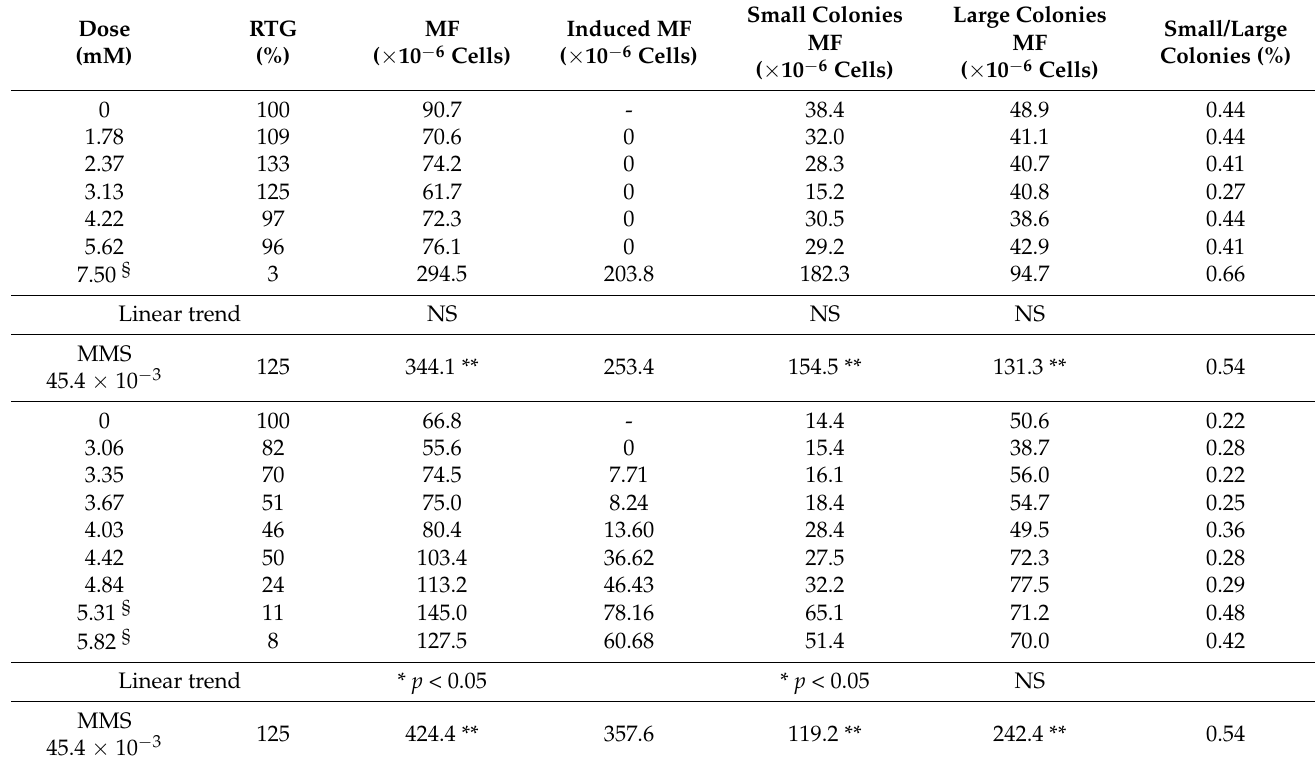
Table 1. Tk + / Tk − mutations induced by 24 h exposure to furan in L5178Y cells.